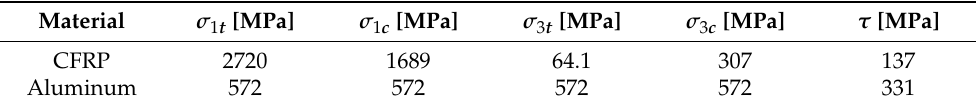
Table 2. Directionally dependent strengths of CFRP and yield strength of aluminum used to find SR from the Tsai-Wu failure criterion.